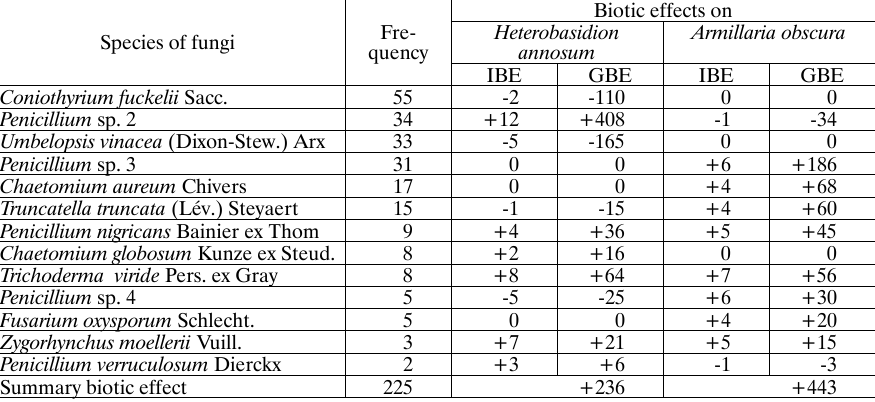
Biotic effect of rhizosphere fungi communities from needle cast-affected 2-year-old Scots pine transplants on the growth of Heterobasidion annosum and Armillaria obscura